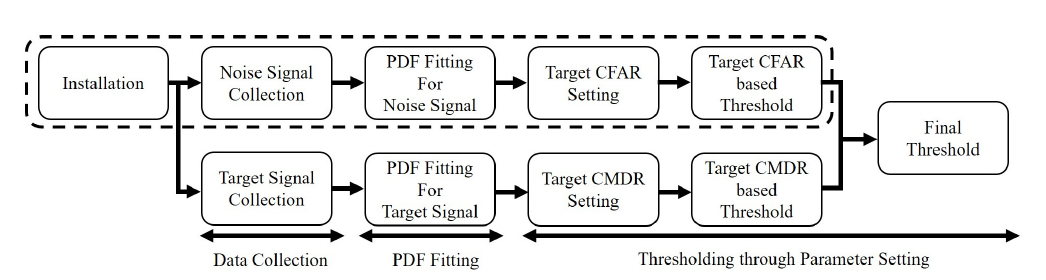
Figure 1. Block diagram of the proposed thresholding